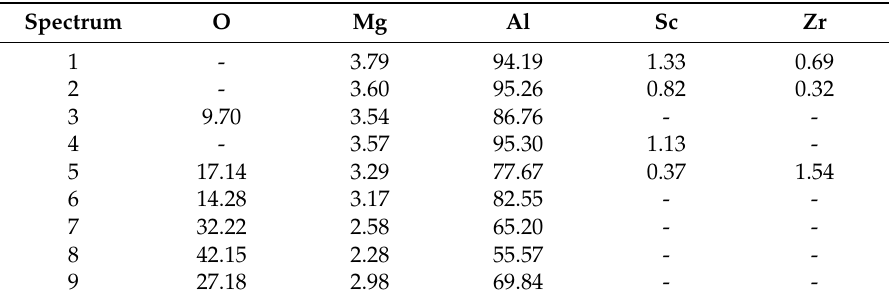
Table 3. EDS analyses (wt. %) of areas indicated in Figure 9.